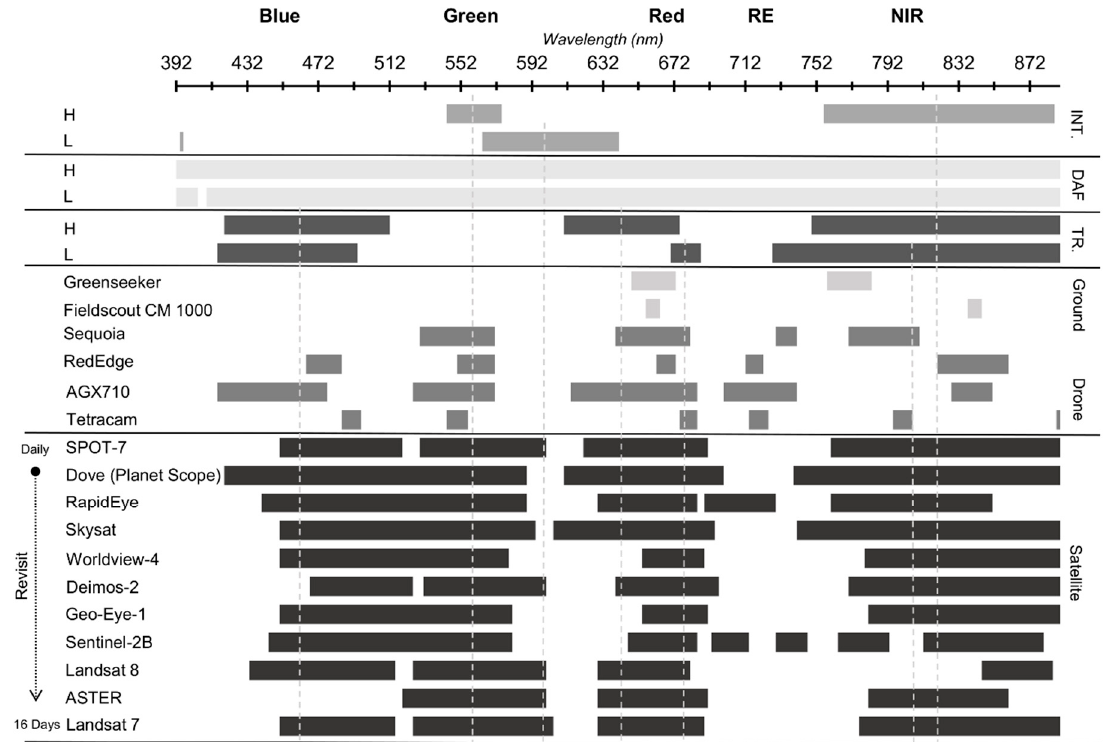
Figure 8. Comparison of bands with significant p values ( p ≤ 0.05), for interactions (INT.) and main effects of days after frost (DAF) and frost treatment (TR.) with bands covered by common ground-, drone- or satellite-deployed sensors. Vertical dashed lines are approximate centers of significant “regions” for frost stress as identified in this study. H = head and L = leaf.